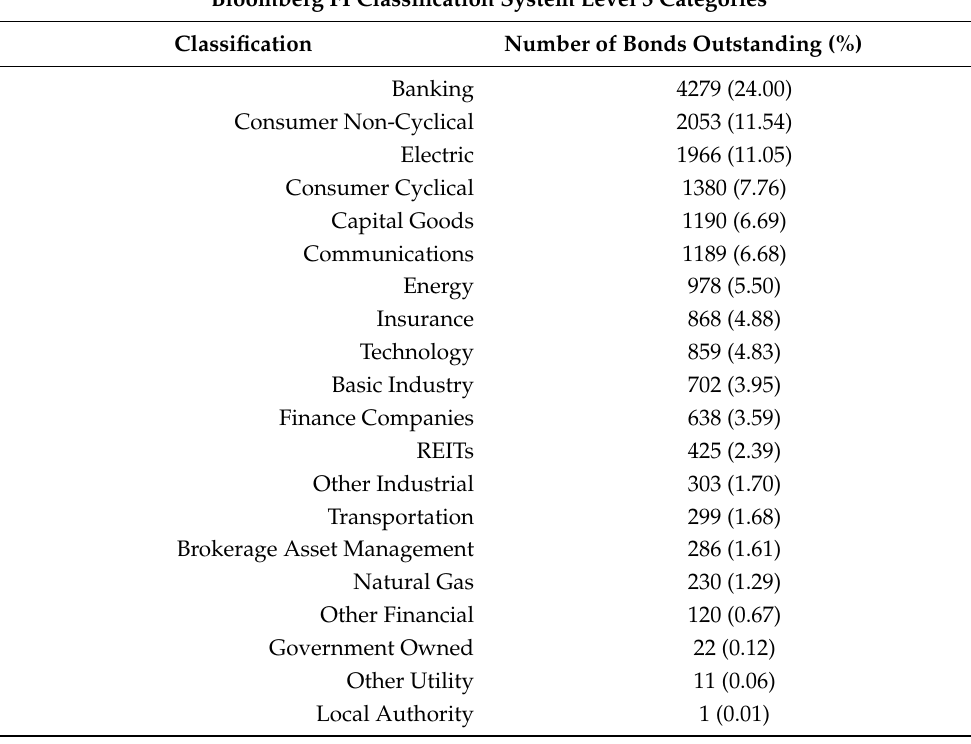
Table 1. The table shows the number of outstanding bonds count, using Bloomberg FI Classification System Level 3 Categories (source: Bloomberg, accessed on 26 September